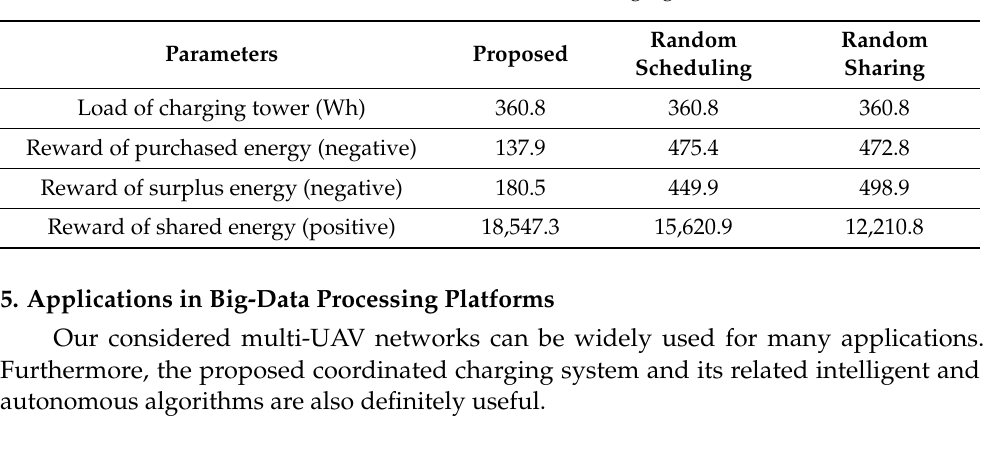
Figure 8. Various reward value distributions in terms of ( a ) total reward, ( b ) purchased energy, ( c ) surplus energy, and ( d ) shared energy, respectively, while comparing the Proposed algorithm, the Random Scheduling algorithm, and the Random Sharing algorithm. Table 3. The list of each obtained reward value and load of charging